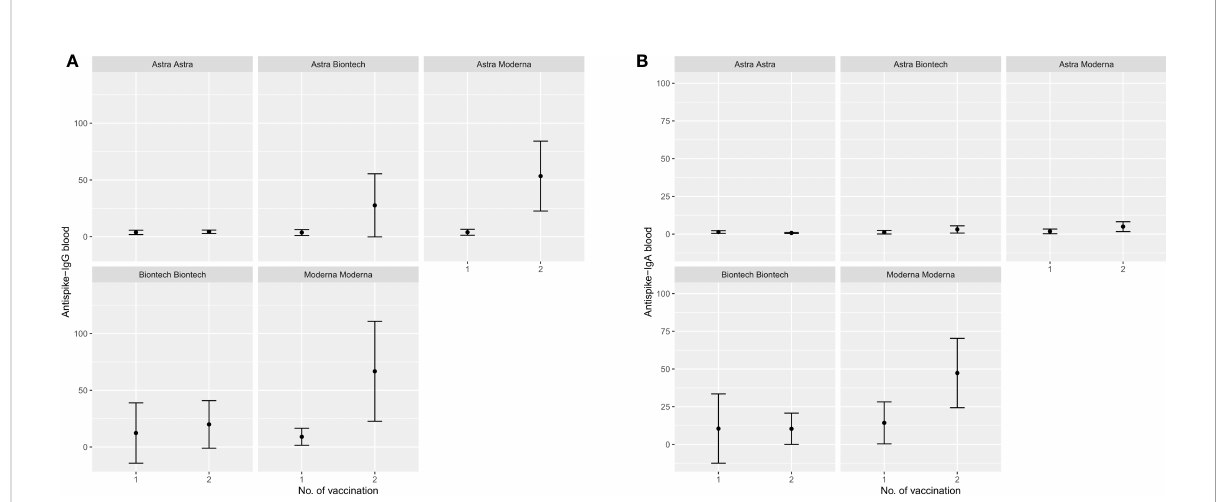
FIGURE 3 Error bar plots depicting the median OD values reached anti-S Abs in blood after fi rst and second vaccination with different vaccination schemes. (A) IgG anti-S Abs in blood, (B) IgA anti-S Abs in blood.